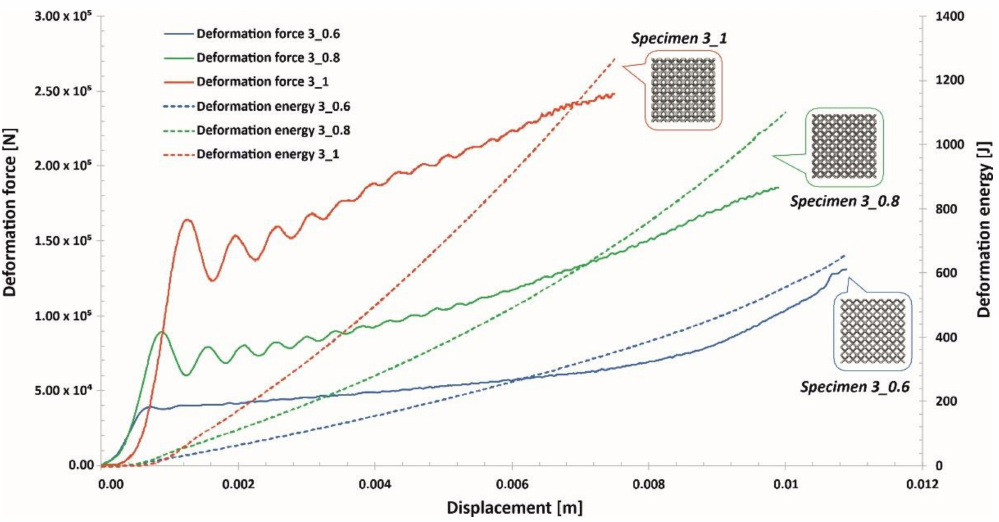
Figure 19. Deformation force and energy plots determined for lattice structures with an elementary unit cell equal to 3 mm under dynamic